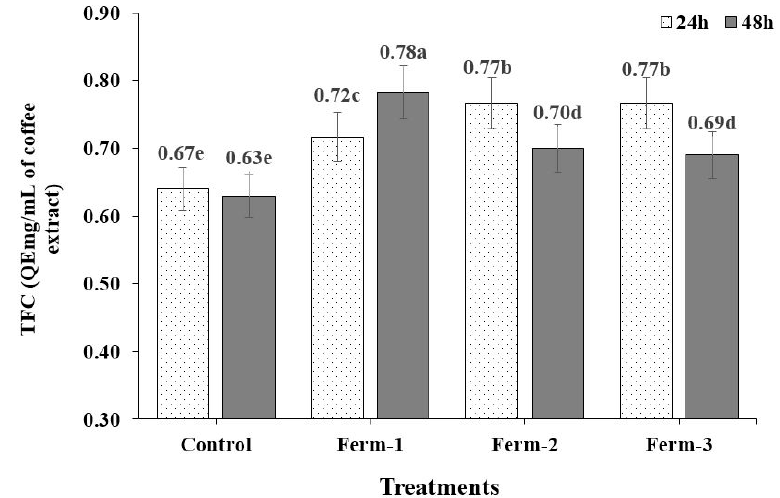
Figure 8. Total flavonoid contents (QEmg/mL of coffee extract) of fermented coffee. The bars with different letters indicate a significant difference ( p < 0.5) among treatments.